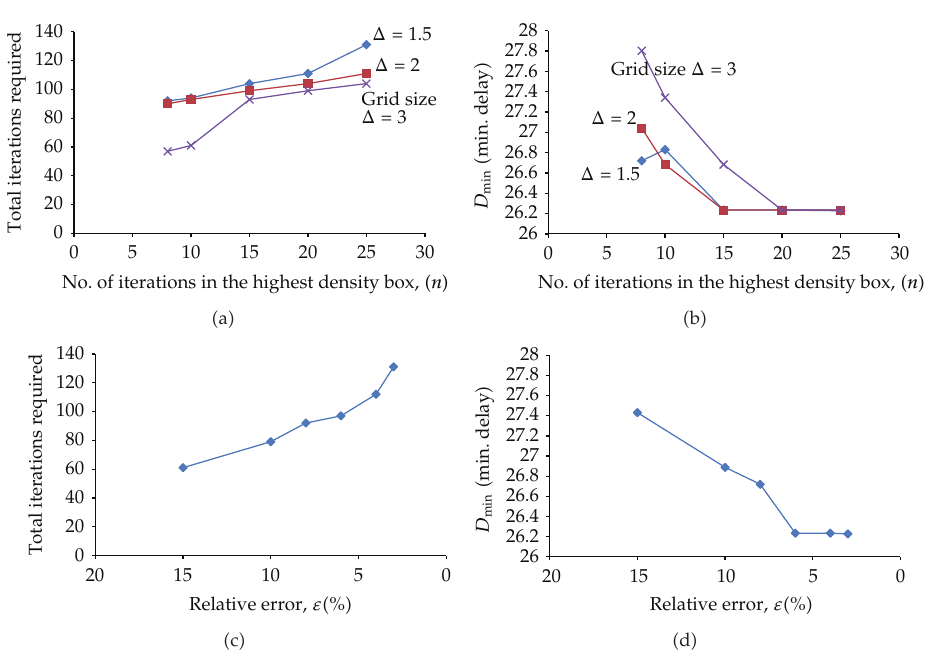
Figure 4: (cid:3) a (cid:4) The number of all iterations against the number of iterations in the highest density box. (cid:3) b (cid:4) The minimum delay against the number of iterations in the highest density box. (cid:3) c (cid:4) The number of all iterations plotted against the relative error (cid:3) the stop criteria in (cid:6) 22 (cid:7)(cid:4) . (cid:3) d (cid:4) The minimum delay against the relative